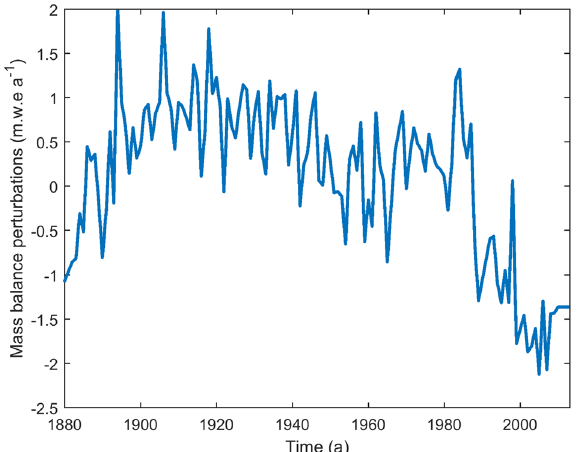
Figure 4. The annual mass balance perturbations are yearly averages of the respective annual mean temperature annomalies. The perturbations were used to simulate the length fluctuations. (URL: www. mathw orks. com).